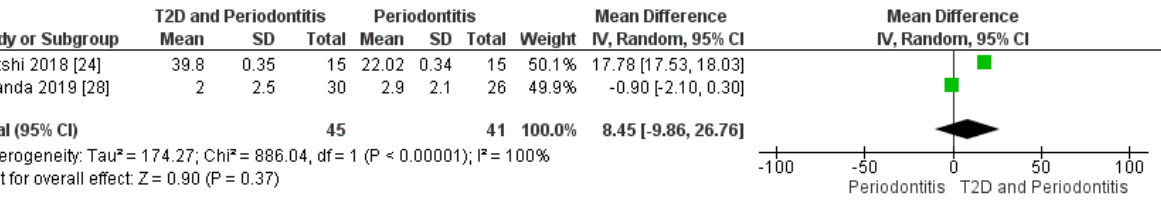
Figure 3. Forest plot for IL-6 levels in the plasma of the periodontitis and the diabetes plus periodontitis groups.